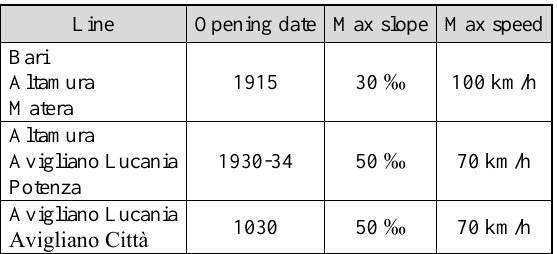
Table 2 defines the three main lines that compose the track.